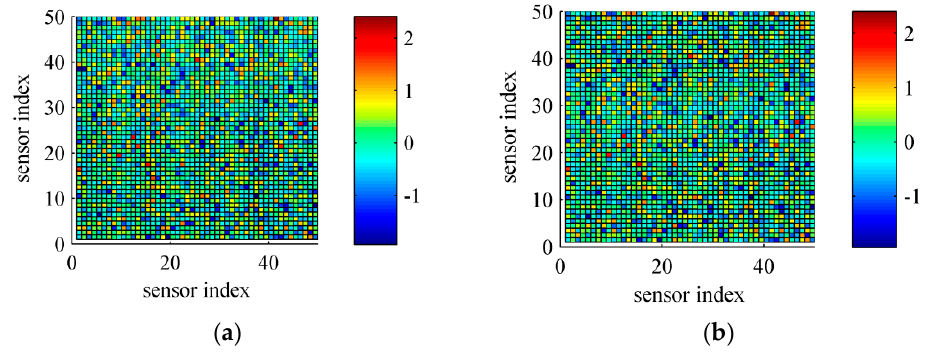
Figure 4. Comparison of actual and estimated phase errors: ( a ) actual phase error; ( b ) estimated phase error. Table 1. Partial actual and estimated values of gain and phase